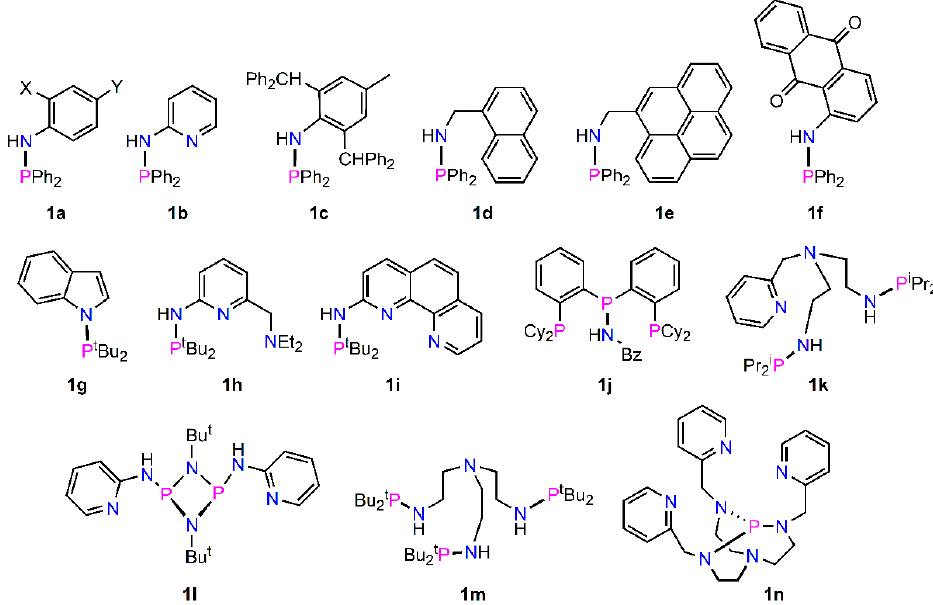
Figure 2. Selected examples of phosphinoamines bearing one or more P–N bonds. A well-known transformation of tertiary phosphines is their oxidation and this re- activity is also the case for phosphinoamines which react with H 2 O 2 , elemental sulfur or selenium or even BH 3 .SMe 2 to give the corresponding P(V) analogues. These